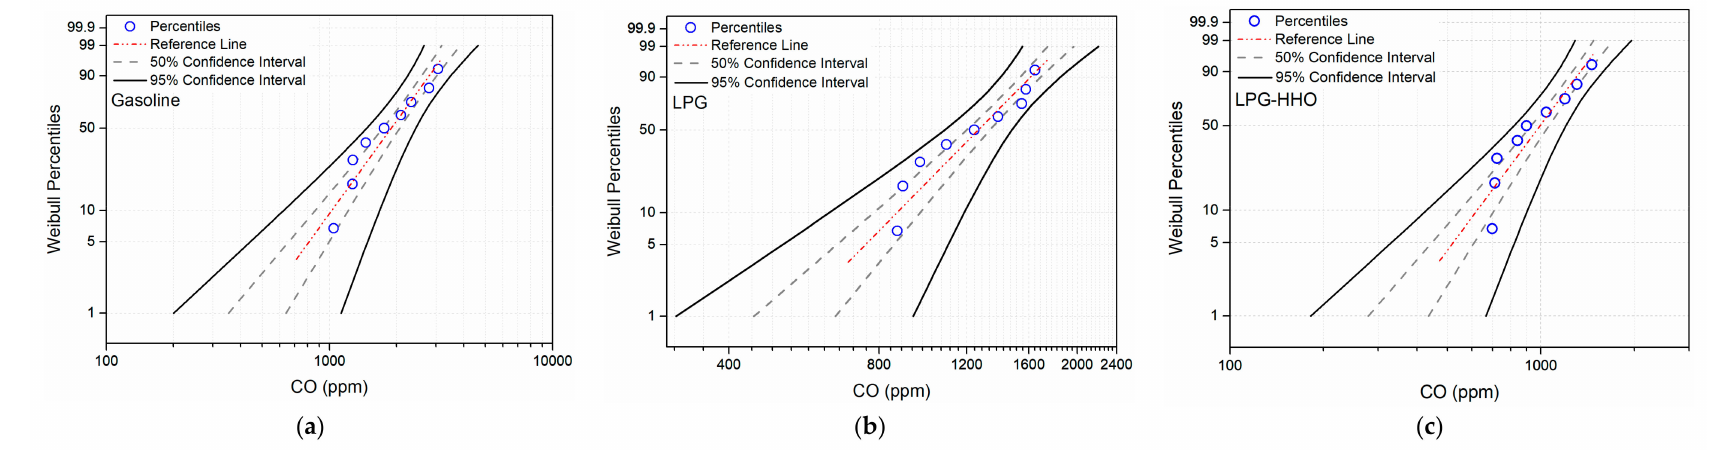
Figure 5. ( a – c ) Weibull probability plot of CO for 50% and 95% CI using gasoline, LPG and LPG-HHO respectively.